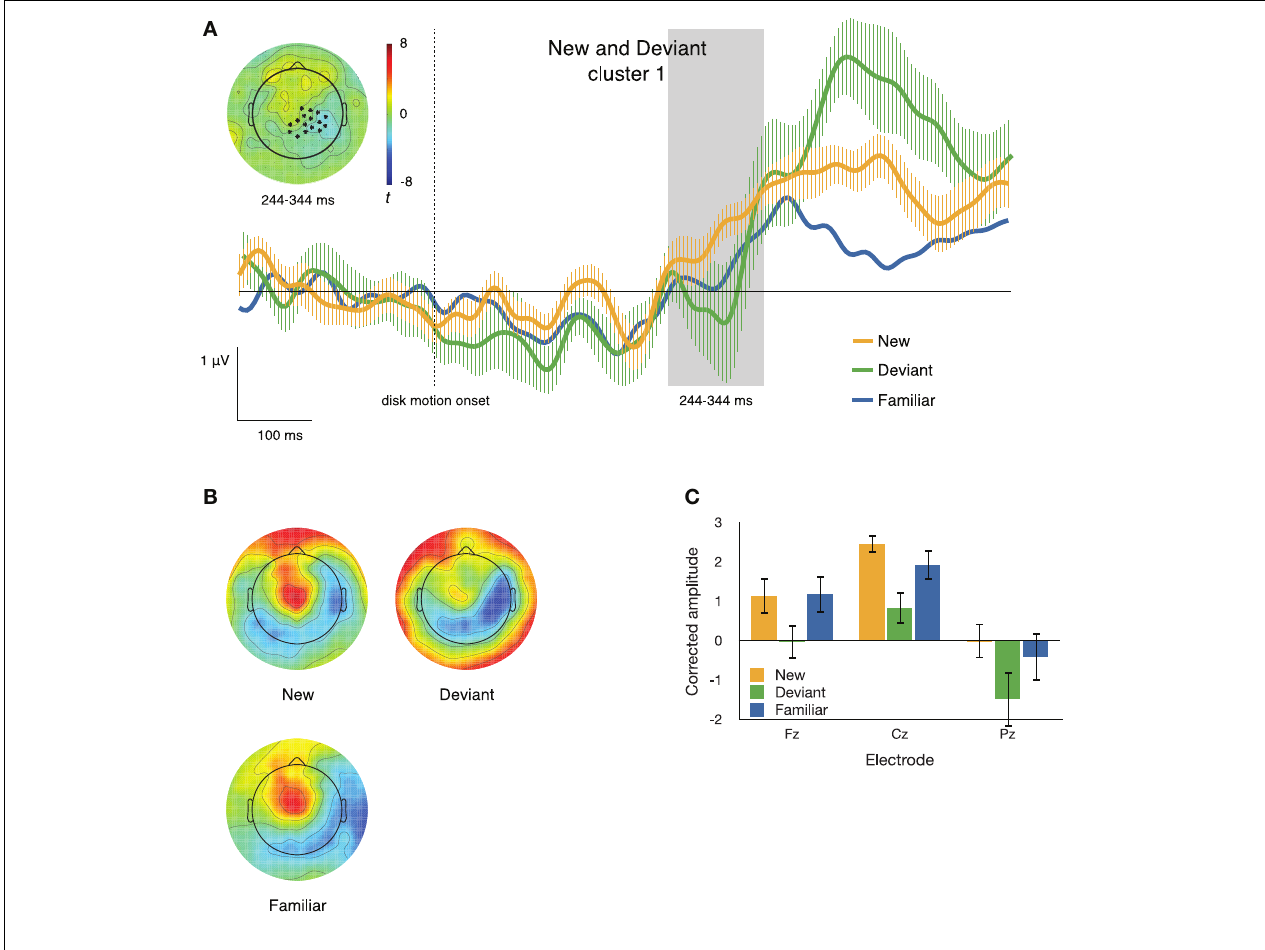
FIGURE 6 | (A) ERPs to new, deviant, and familiar sequence items at one of the two clusters differentiating these conditions. The inset topographical plot shows the locations of the electrodes making up the slightly right-lateralized centro-parietal cluster and the distribution of t values at 244–344ms after disk motion onset; the traces show ERPs at those electrodes. (B) Topographical plots of the spatial distribution of voltage